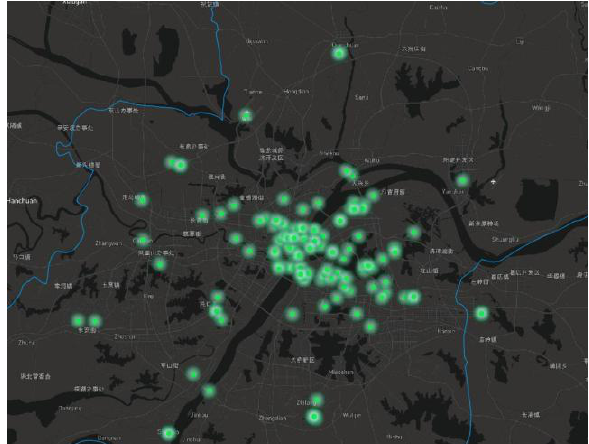
Figure 4. Actual waterlog zone in